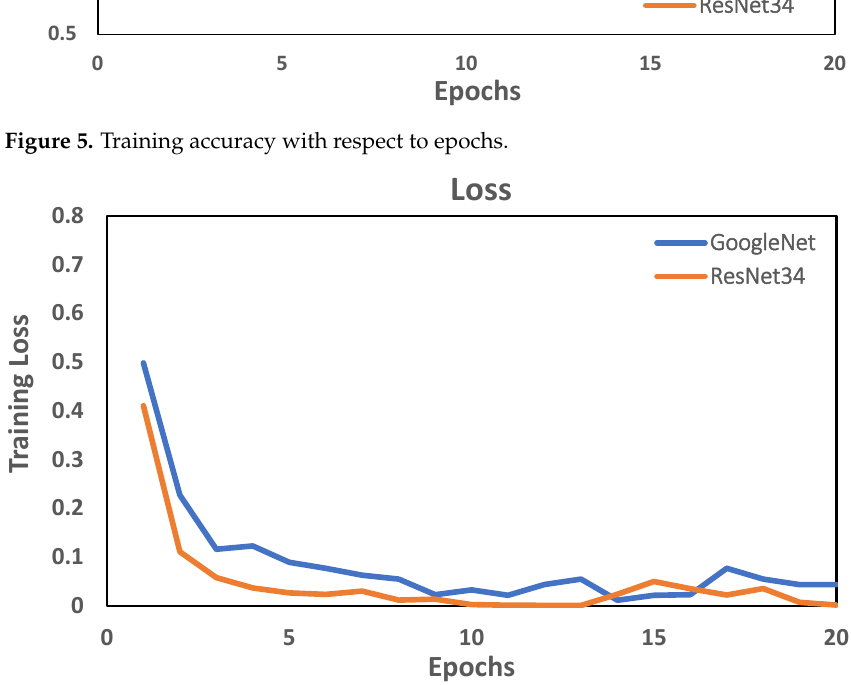
Figure 6. Training loss with respect to epochs.